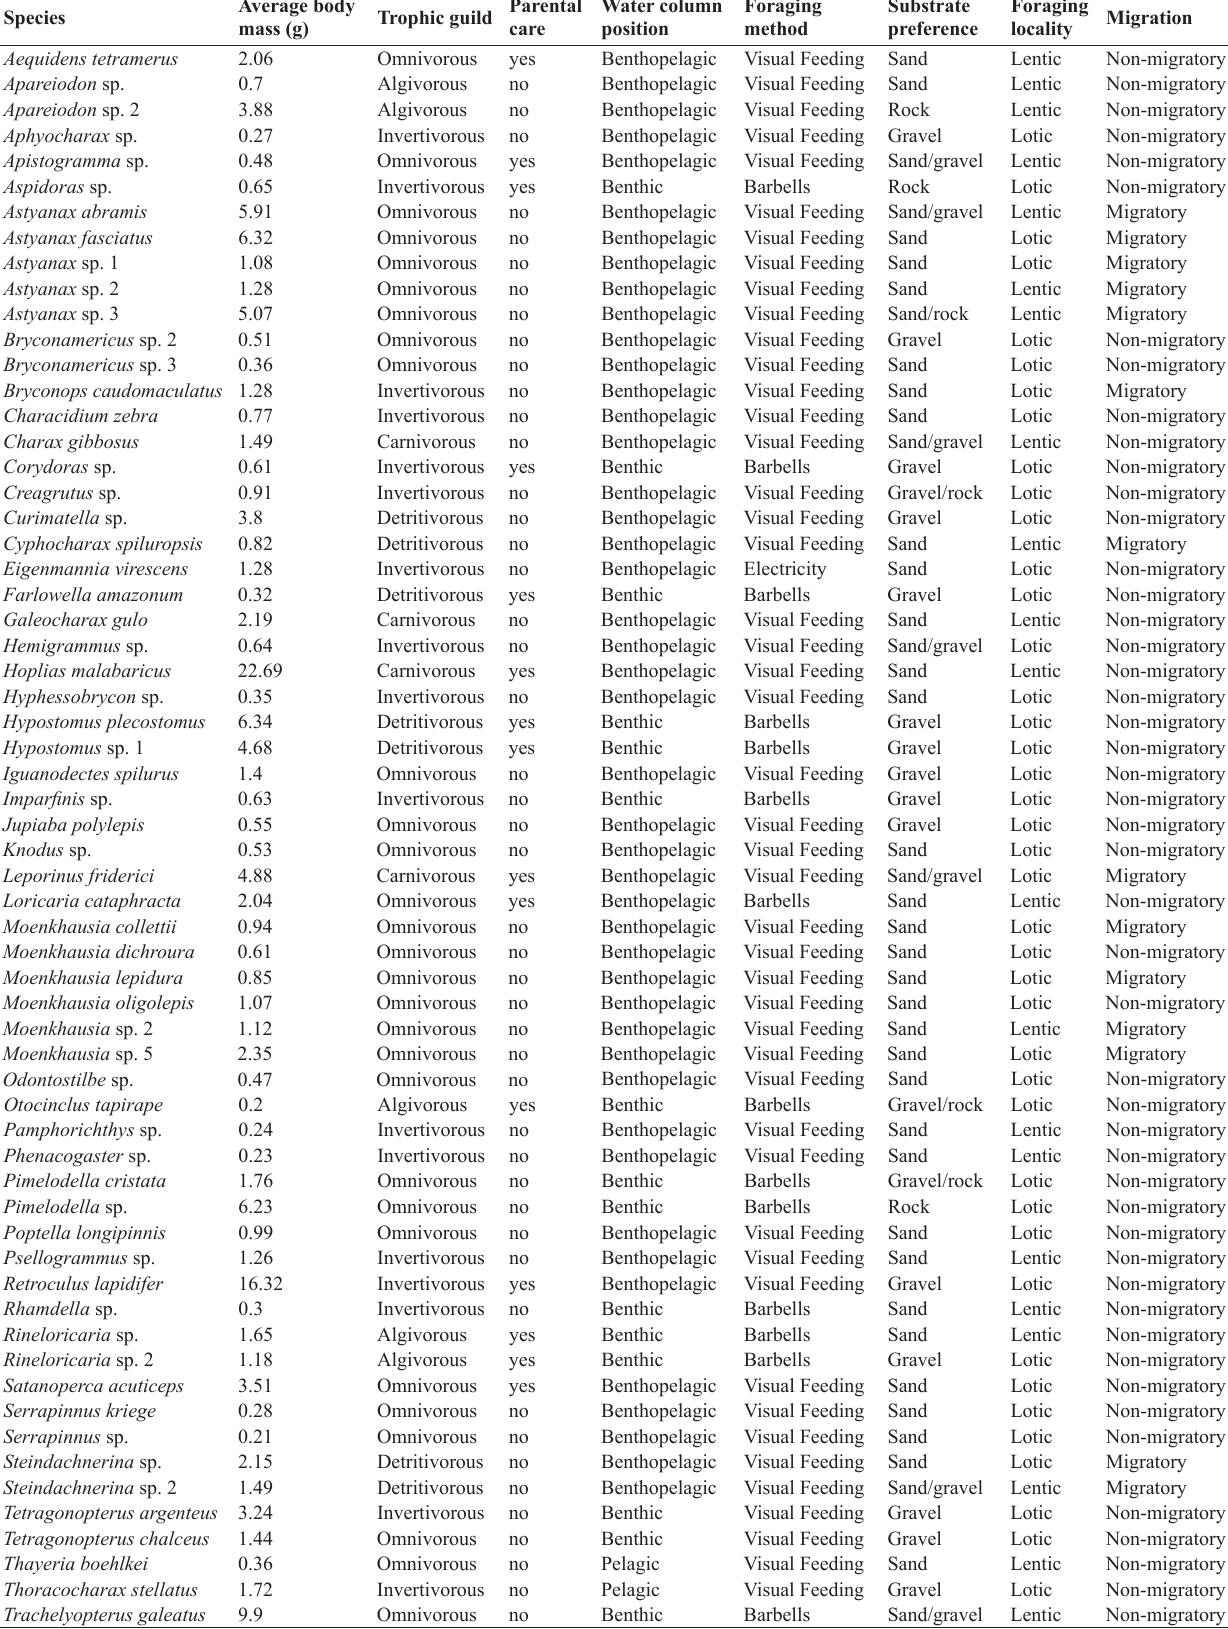
Table S1. Functional traits of species sampled in headwater streams of the Araguaia and Tocantins river